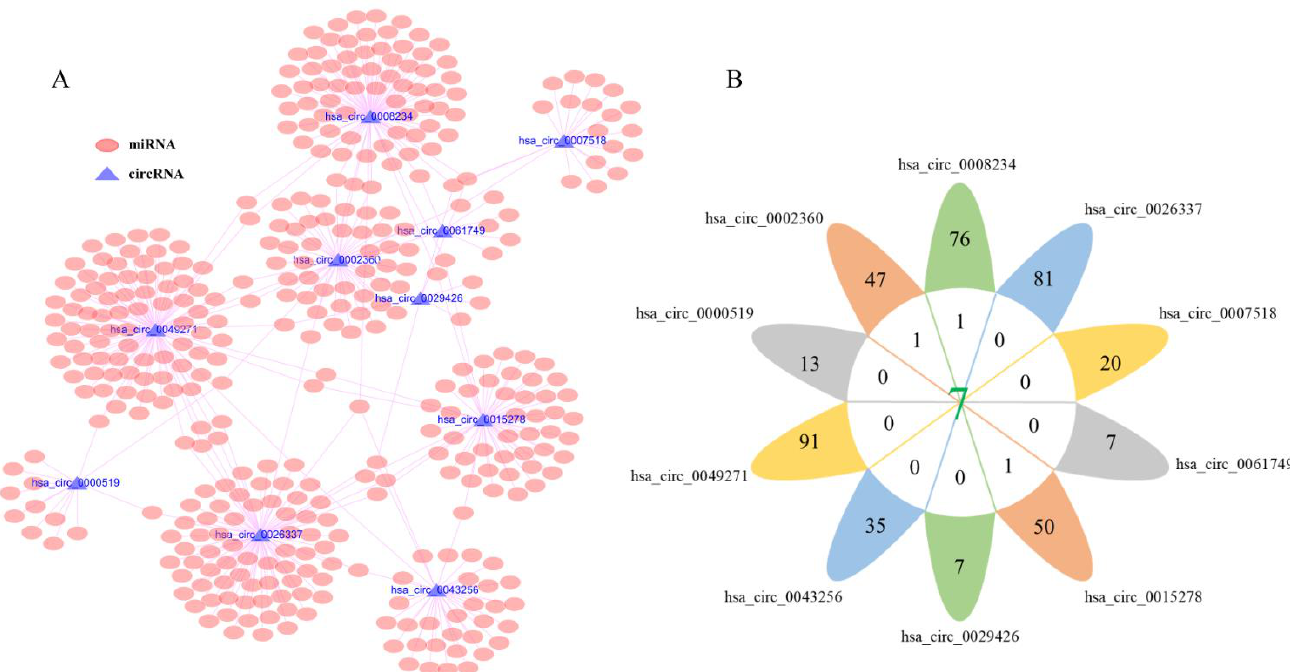
Figure 3. Identification of circRNA – miRNA interactions. ( A ) Prediction of target miRNAs of DECs via using the circbank, the pink oval represents miRNAs, blue triangle represents circRNA. ( B ) Venn diagram analysis and 3 miRNAs were determined.